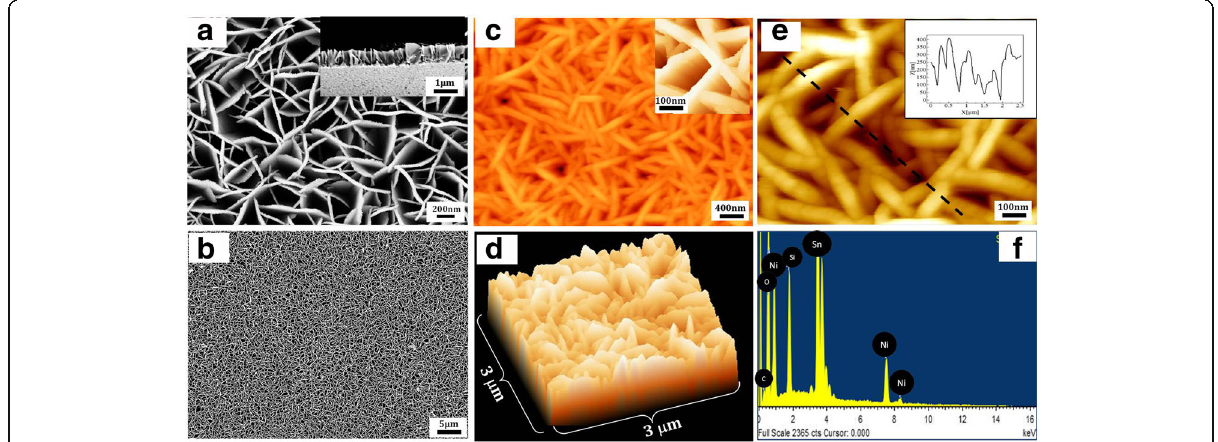
Fig. 1 a , b Surface morphologies of NiO nanostructures showing petal-like structure with its cross-sectional view (inset). c – e AFM images with